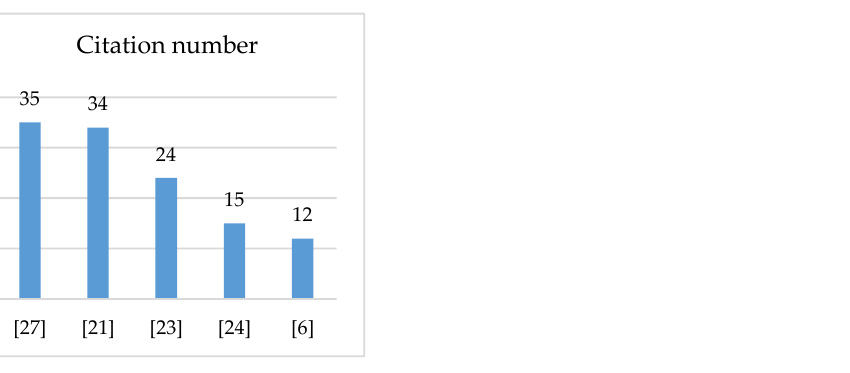
Figure 11. Works with the highest number of citations on methodologies based on IEC 61850.